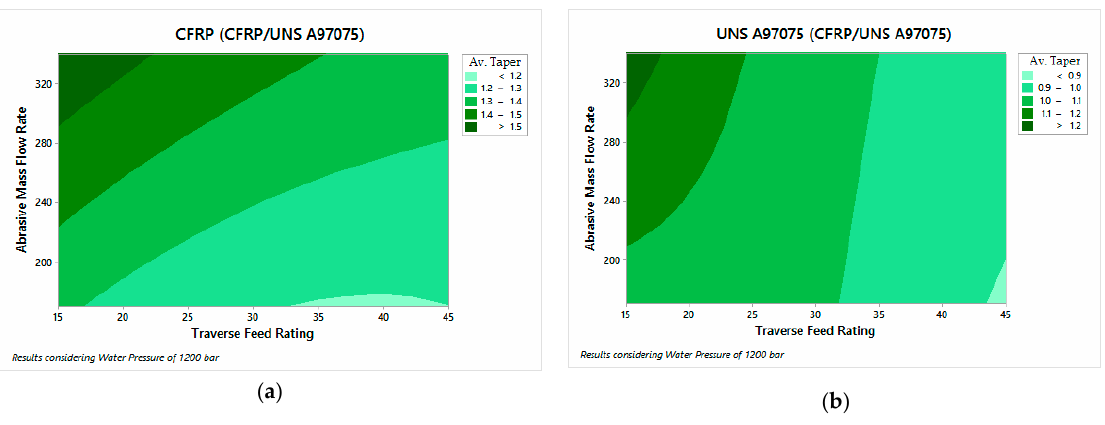
Figure 11. Average kerf taper for CFRP/USN A97075/ configuration: ( a ) CFRP; ( b ) UNS A97075.